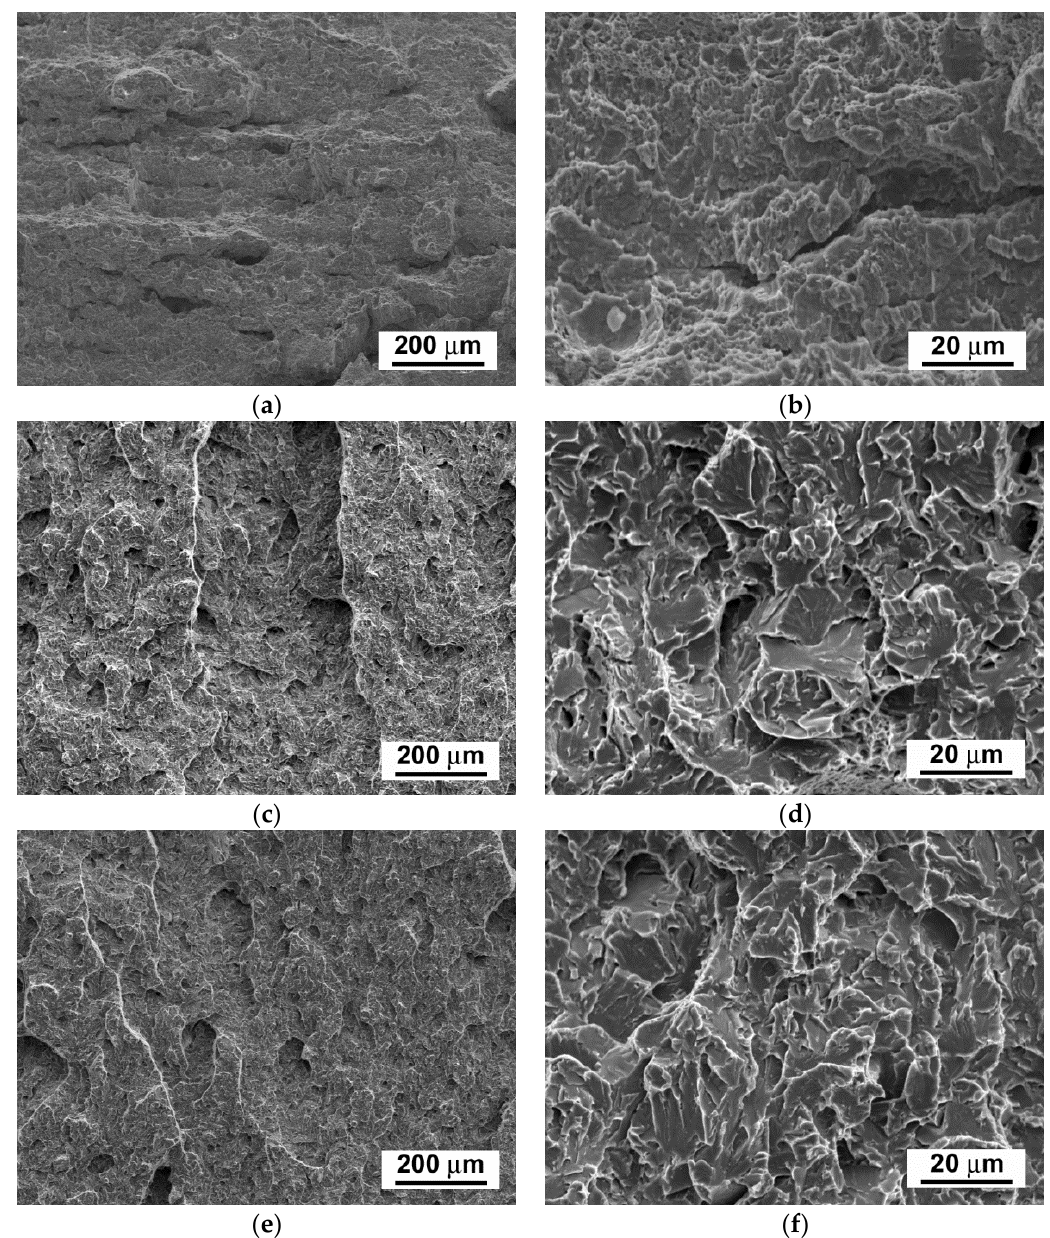
Figure 10. SEM fractographs of fractured impact toughness test specimens after dynamic impact bending tests of P92 steel in various material conditions: ( a , b ) N&T, ( c , d ) 600 °C/2.5 kh, and ( e , f ) 600 °C/5 kh.